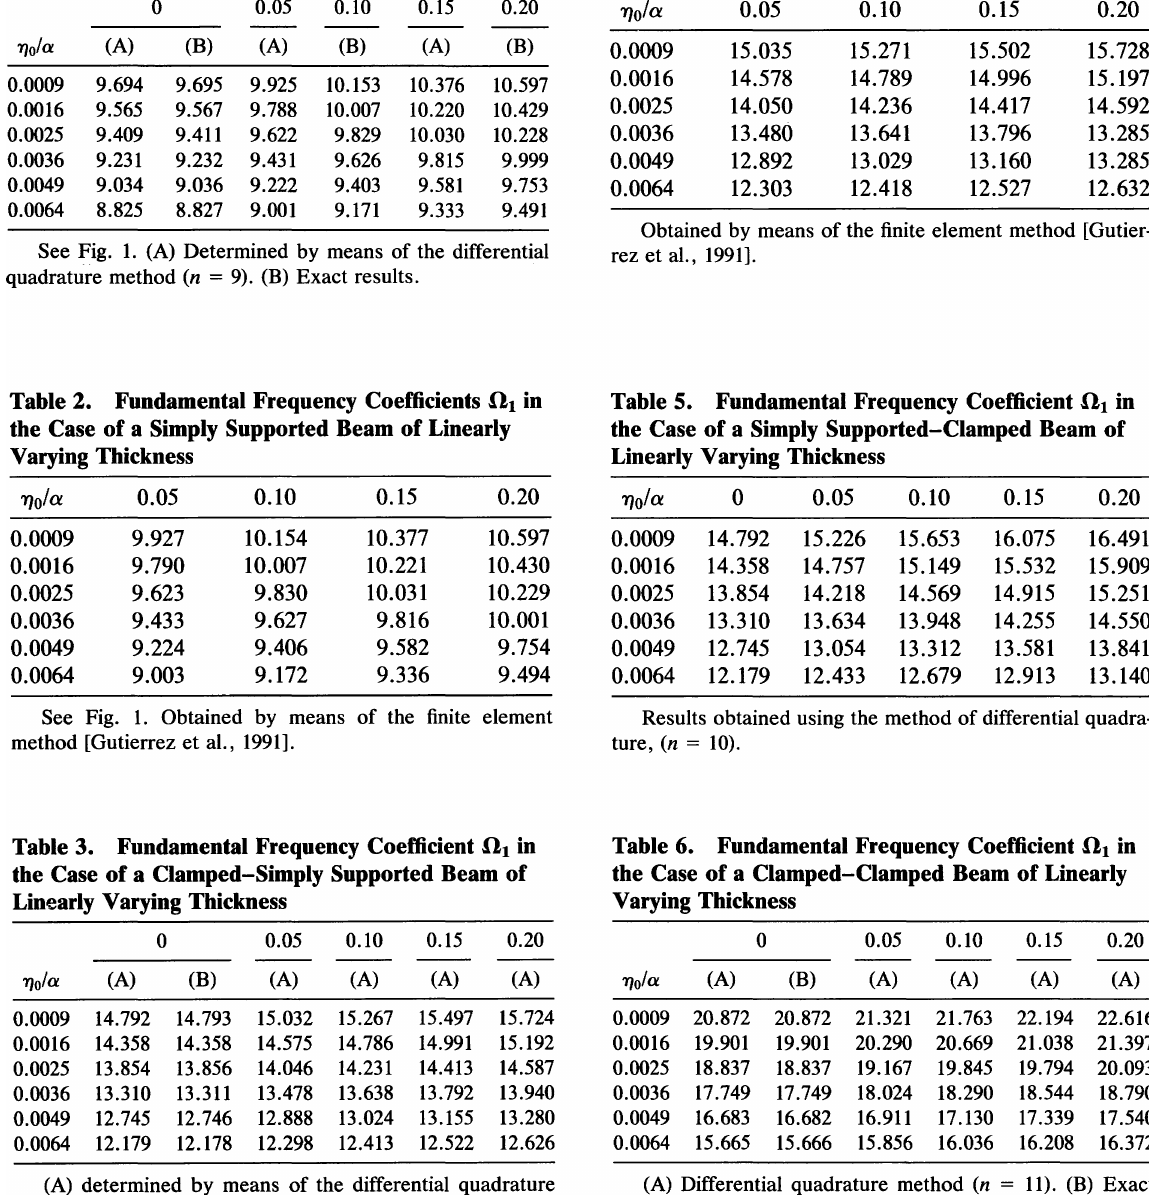
Table 4. Fundamental Frequency Coefficient fil in